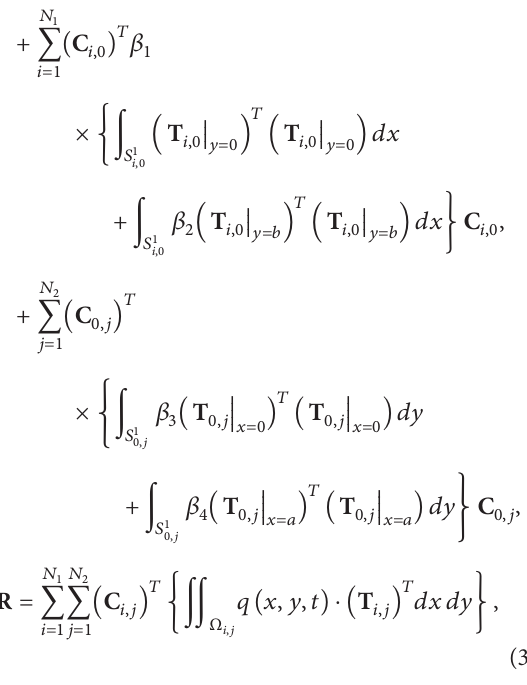
Figure 5: Cover system and manifold element of the thin